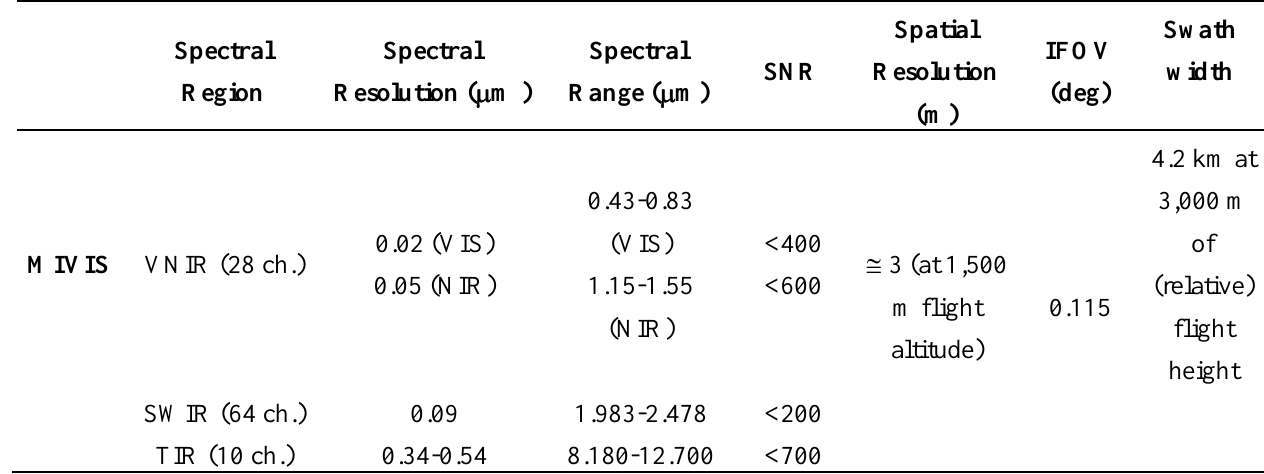
Table 1. Characteristics of the MIVIS sensor used for this